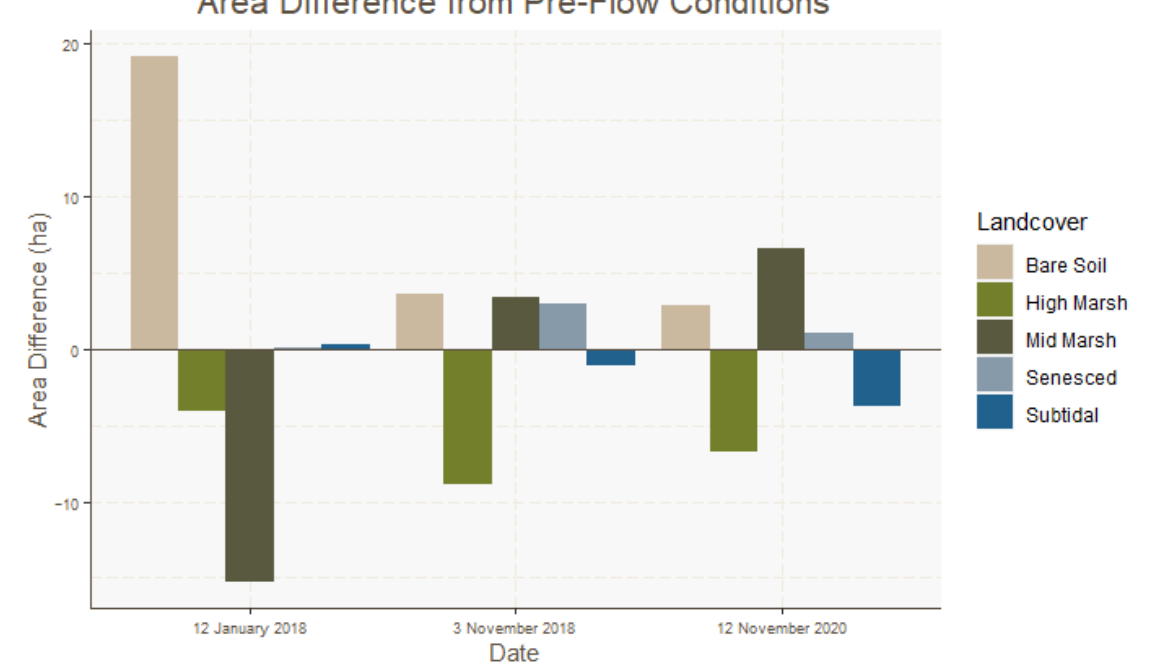
Figure 6. Difference of landcover class area (ha) compared to pre-flow conditions (November 2017). Bars are clustered by date.